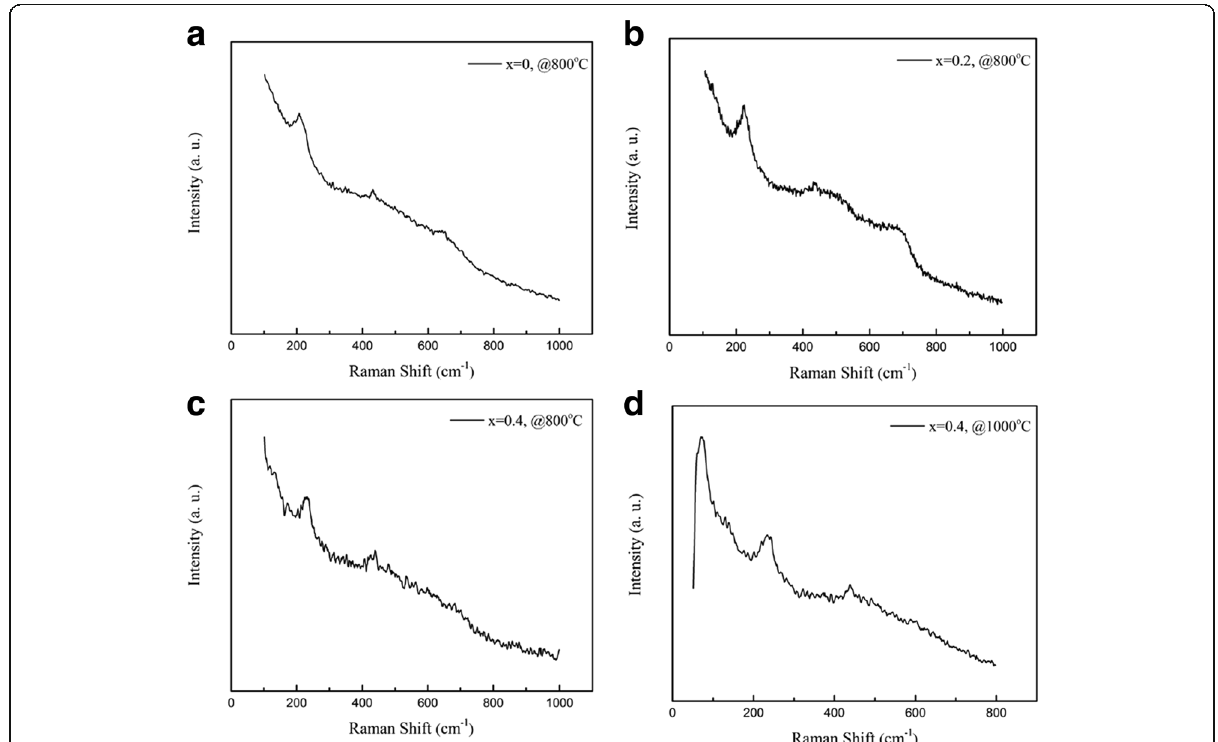
Fig. 6 Raman spectra of the (La 1 − x Pr x ) 0.67 Ca 0.33 MnO 3 nanoparticles with a x = 0.0 and b x = 0.2 and post-annealed at 800 °C, and with x = 0.4 and post-annealed at c 800 °C and d 1000